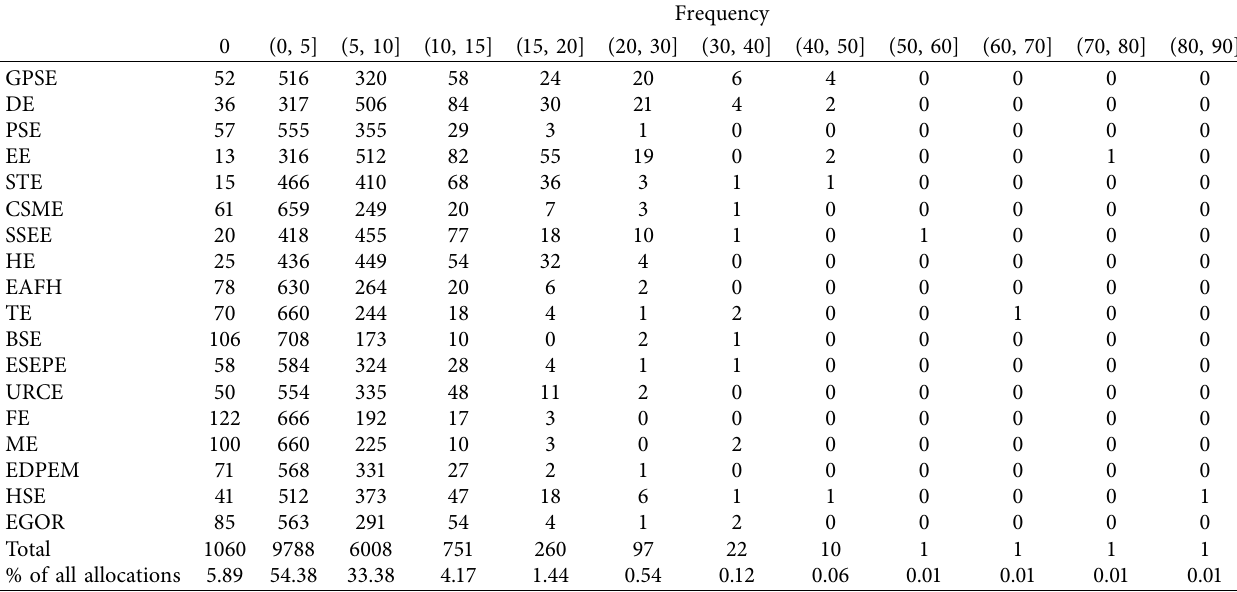
Table 3: Distribution characteristics of the frequency.